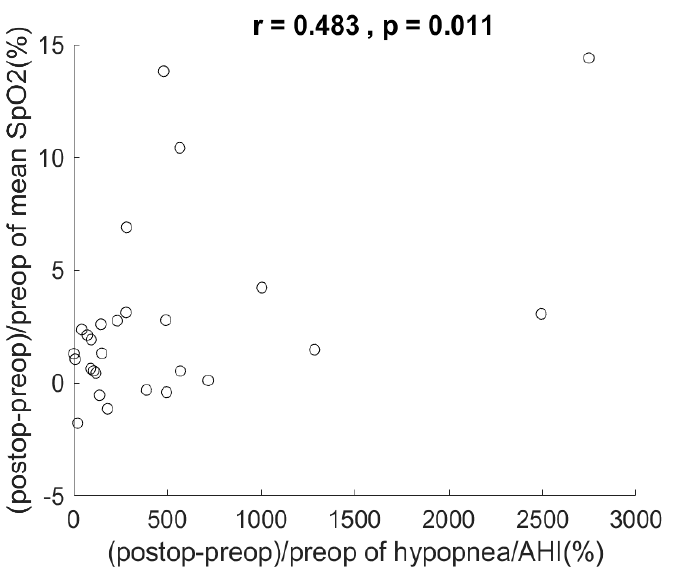
Figure 8. Scatter plot and correlation of proportion change of hypopnea/AHI (defined here as (postoperative-preoperative)/preoperative fraction of hypopnea in AHI) vs. change of mean SpO 2 (defined here as (postoperative-preoperative)/preoperative mean SpO 2 ). It shows that the improvement of mean SpO 2 was positively related to the proportional increase of hypopnea/AHI.